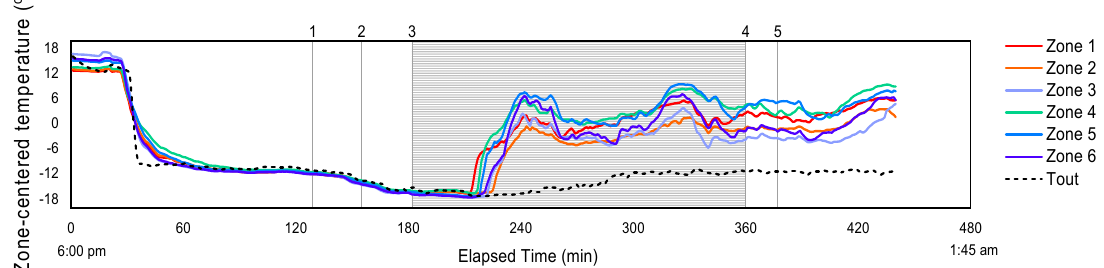
Figure 5. Ceiling-centered temperature profile representing 6 zones inside a pig trailer during a Very Cold evening trip. Zones 1 to 3 representing trailer top deck, and Zones 4 to 6 representing bottom deck. Events occurred during the trip are numbered on the figure as follows: 1. Arrival at a commercial pig barn; 2. Loading; 3. En route; 4. Arrival at abattoir; 5. Unloading.